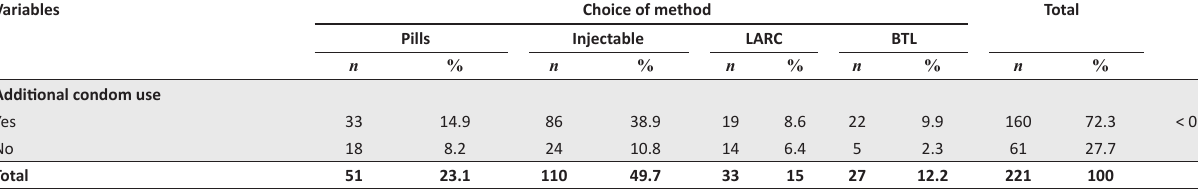
TABLE 1: Distribution of modern contraceptives as per choice of method. Variables Choice of method